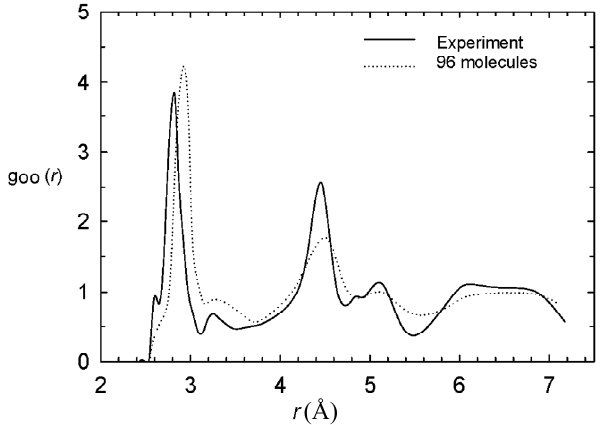
Figure 2. O-O RDF for ice I h at 273 K (DRSLL), for a 96-molecule system. The ambient pressure experimental data is from [25] at 220 K. The 192-molecule is very similar in RDF to the 96-molecule